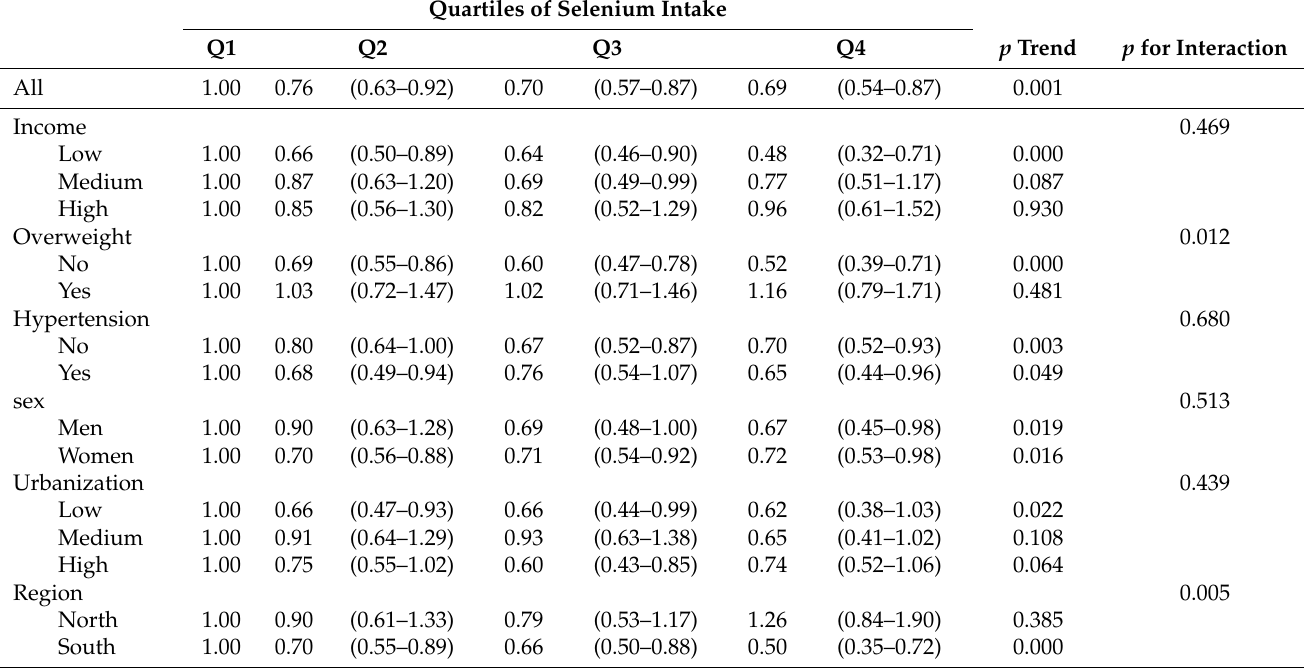
Table 4. ORs (95% CIs) for global cognitive scores < 7 across quartiles of selenium intake among Chinese adults aged ≥ 55 y by sample characteristics: China Health and Nutrition Survey ( n = 4852). Quartiles of Selenium